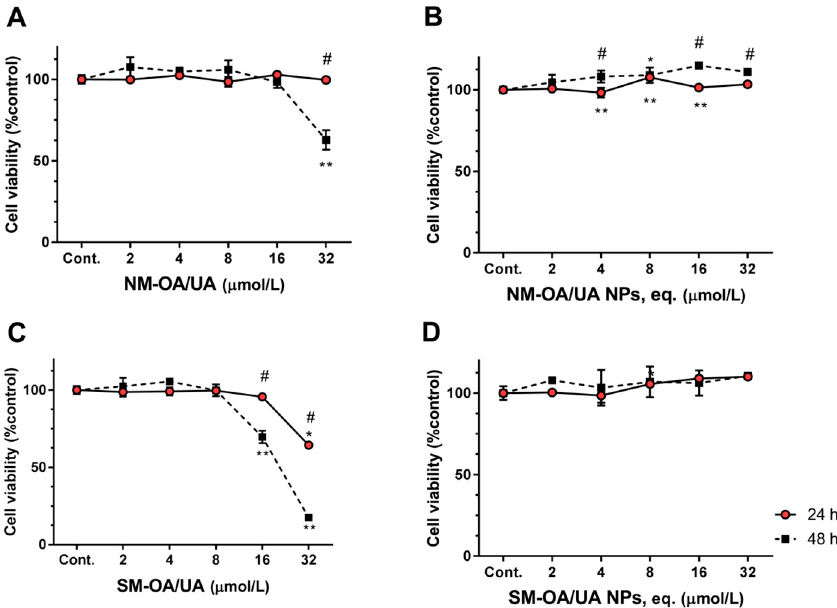
Figure 2. The effect of OA/UA on HepG2 (human hepatoma) cells viability. HepG2 cells were exposed to the natural mixture of oleanolic and ursolic acids (NM-OA/UA) ( A ), NM-OA/UA nanoparticles (NPs) ( B ), the synthetic mixture of oleanolic acid and ursolic acids (SM-OA/UA) ( C ), SM-OA/UA NPs ( D ), for 24 and 48 h, as denoted. Statistically significant differences, p < 0.05, are denoted with * or **, in relation to respective control at 24 or 48 h, respectively; # denotes statistical differences for incubation periods at indicated concentration. The results are the mean ± S.D. of n = 4.